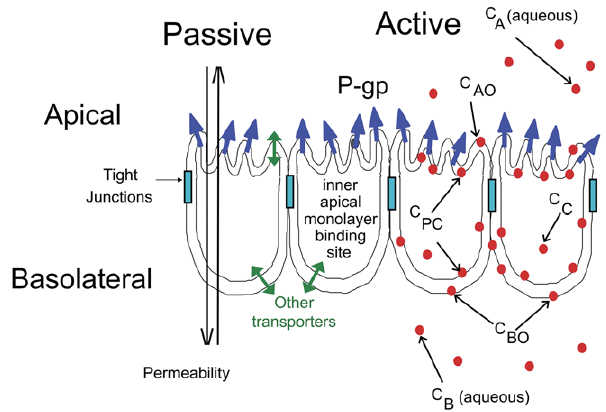
Figure 1. Model of the Confluent Monolayer of Polarized Cells. Model of a confluent cell monolayer, with the apical membrane on top and the basolateral membrane below, where it binds to the polycarbonate insert. P-gp expressed on the apical membrane transports substrate from the inner apical membrane monolayer into the apical chamber. The concentration of substrate in the apical and basolateral chambers, C A and C B , are measured, while the concentration of substrate in the inner plasma membrane, C PC , and the cytosol, C C , are predicted as part of the mass action modeling and data fitting process. Some compounds use other transporters expressed by the MDCKII- hMDR1 confluent cell monolayer. Passive permeability occurs in both